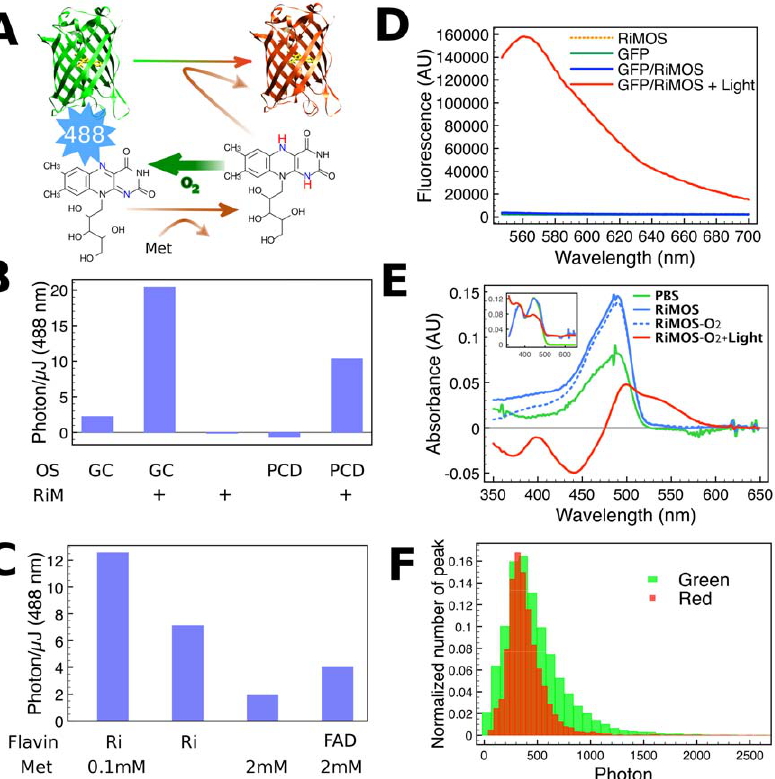
Figure 1. Photoconversion of EGFP by Reduced Flavin. (A) Summary of interactions among EGFP (chromophore is shown yellow), riboflavin (chemical structure), methionine (Met), molecular oxygen (O 2 ), and blue light (488 nm wavelength). Photoreduction of riboflavin results in acquisition of two hydrogens (red) with a bond rearrangement between two nitrogen atoms (blue). Reduced riboflavin is easily oxidized by O 2 , but an oxygen scavenger system removes it to protect reduced state of riboflavin. (B) Photoconversion efficiency of fixed E. coli expressing EGFP in various surrounding media. The measurements are done as in Figure S1. OS, oxygen scavenger; GC, glucose oxidase/catalase; PCD, protocatechuate-3,4- dioxygenase; RiM, 0.1 mM riboflavin and 0.5 mM methionine. (C) Photoconversion efficiency of fixed E. coli expressing EGFP in the modified RiMOS (riboflavin, methionine and oxygen scavenger). Ri, 0.1 mM riboflavin; Met, methionine; FAD, 0.1 mM flavin adenine mononucleotide. Oxygen scavenger is included in all media. (D) Fluorescence emission spectra of EGFP (excitation with 532 nm). (E) Absorption spectra of EGFP in response to the change in the surrounding environment. PBS was used as blank for EGFP + PBS whereas RiMOS was used as blank for series of measurements using EGFP + RiMOS. Inset shows absorption spectra of a RiMOS solution where the color code is the same as EGFP, and PBS was used as blank (F) Histogram of number of photons emitted from EGFP in both green and red forms measured by single molecule imaging.